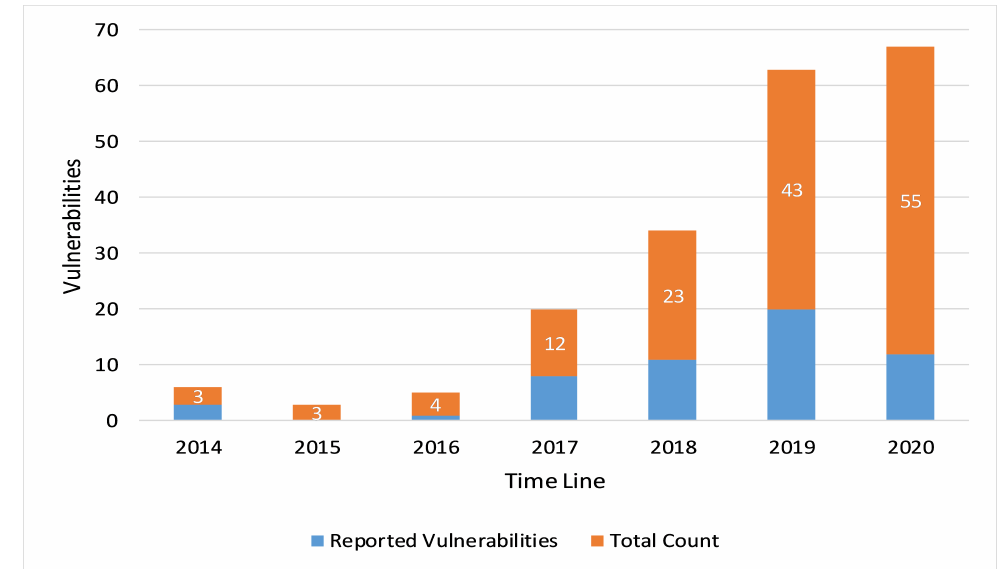
Figure 1. MQTT vulnerabilities reported in NVD and CVE during the 2014–2020